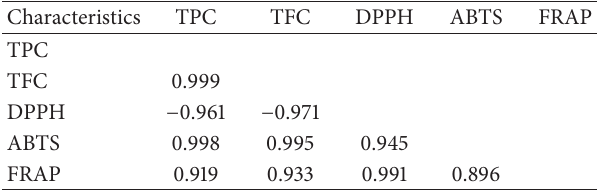
Table 2: Correlation of antioxidant capacity and total phenolic and total flavonoid contents.